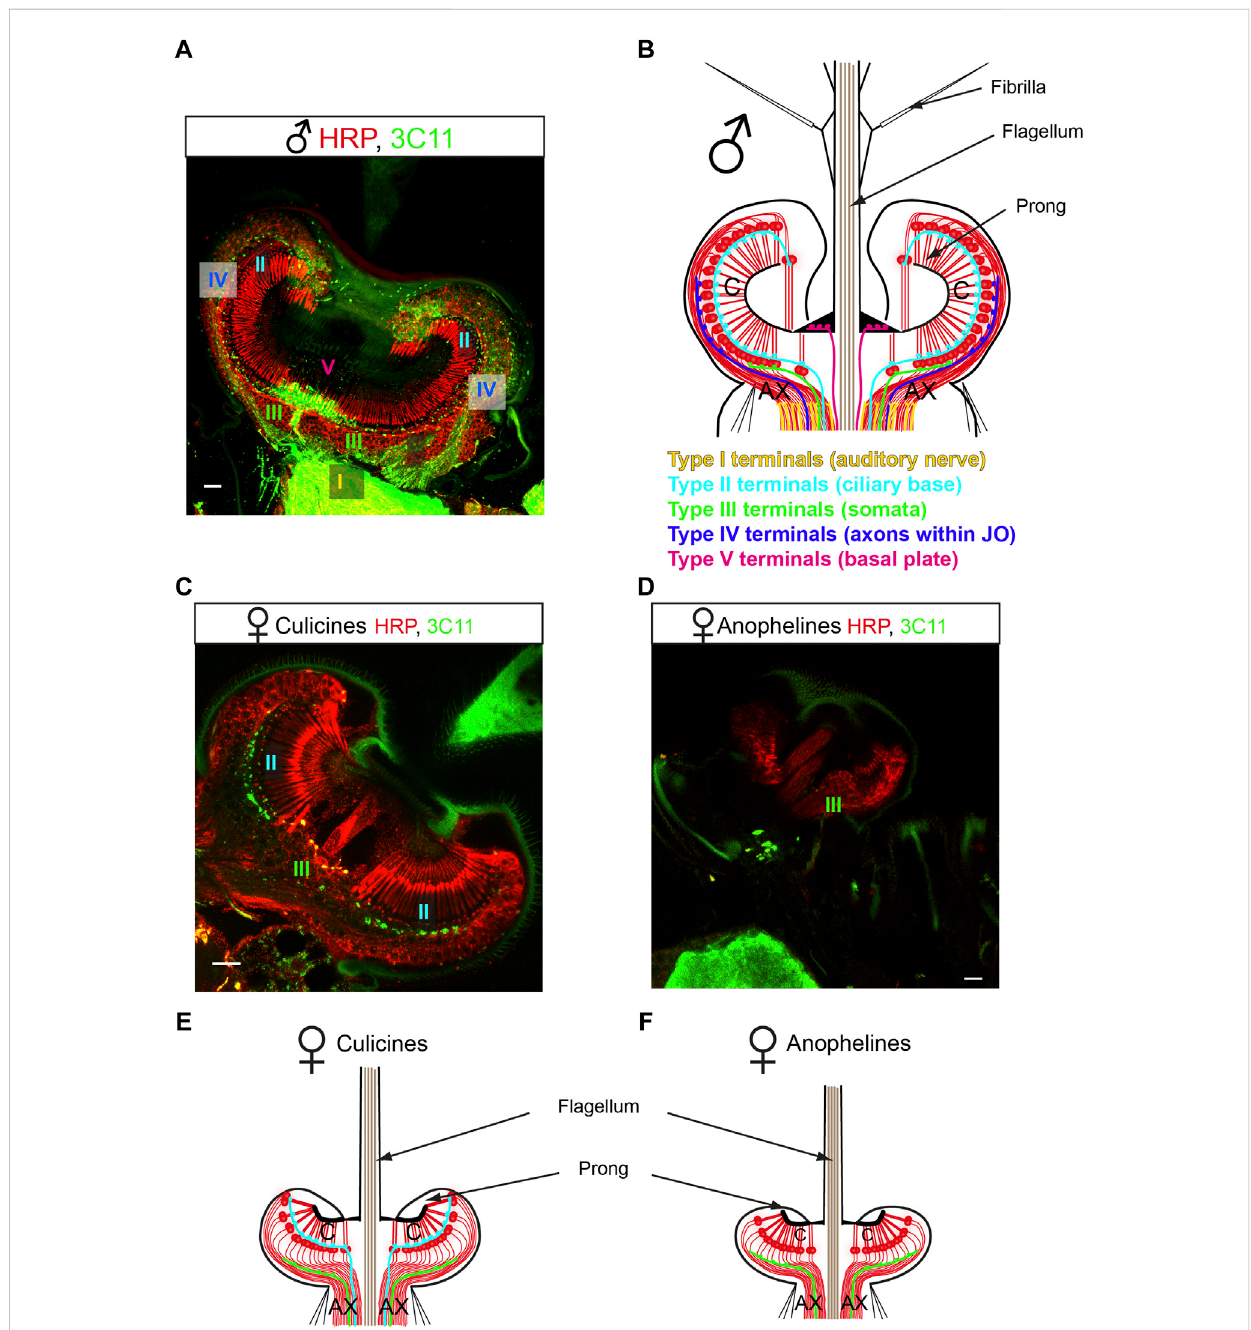
FIGURE 3 Newnomenclatureproposedforthemosquitoauditoryefferentsystem. (A,C,D) EfferentterminalsinnervatethemaleandfemalemosquitoJOs.JO horizontal sections stained with a presynaptic marker (mAb 3C11, anti-synapsin, green) and counterstained with a neuronal marker (anti-HRP, red). (A) Male mosquitoes (here a Cx. quinquefasciatus male JO) present an extensive efferent innervation that targets the auditory nerve (type I terminals), the ciliary basis (type II terminals), the somata (type III terminals), the axons within the JO (type IV terminals) and the basal plate (type V terminals). (B) Schematic fi gure summarising the distribution of efferent presynapticterminals in the male JO. This pattern is consistent in males across anopheline and culicinemosquitoes. (C,D) Femalemosquitoespresentareducedefferentsystemcomparedtomales,butdifferencesareclearbetweenculicines (C) and anopheline (D) mosquitoes. (C) Culicine female (here a Cx. quinquefasciatus female JO) present type II and III terminals, innervating the auditory neuron cilia and somata, respectively. (D) An. gambiae females present a drastically reduced efferent innervation, with some sparse type III terminals observed acrosstheneuronalcellbodies. (E,F) Schematicssummarizingthedistributionoftheauditoryefferentterminalsinfemales.Culicinefemales (E) presenta more extensiveauditory efferent pattern compared to anophelinefemales (F) . Modi fi edfrom (Andrés et al.,2016)and (Suet al., 2018). AX: afferent axons; C: auditory cilia. Scale bar: 10 μ